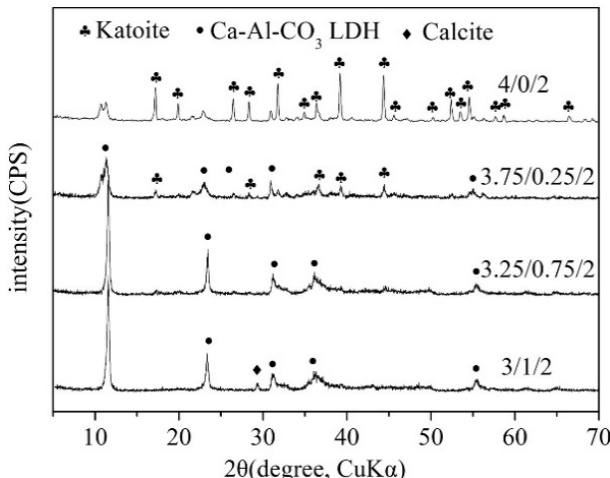
Figure 3. X-ray diffraction (XRD) patterns of Ca-Al-CO 3 layered double hydroxide (LDH) prepared by